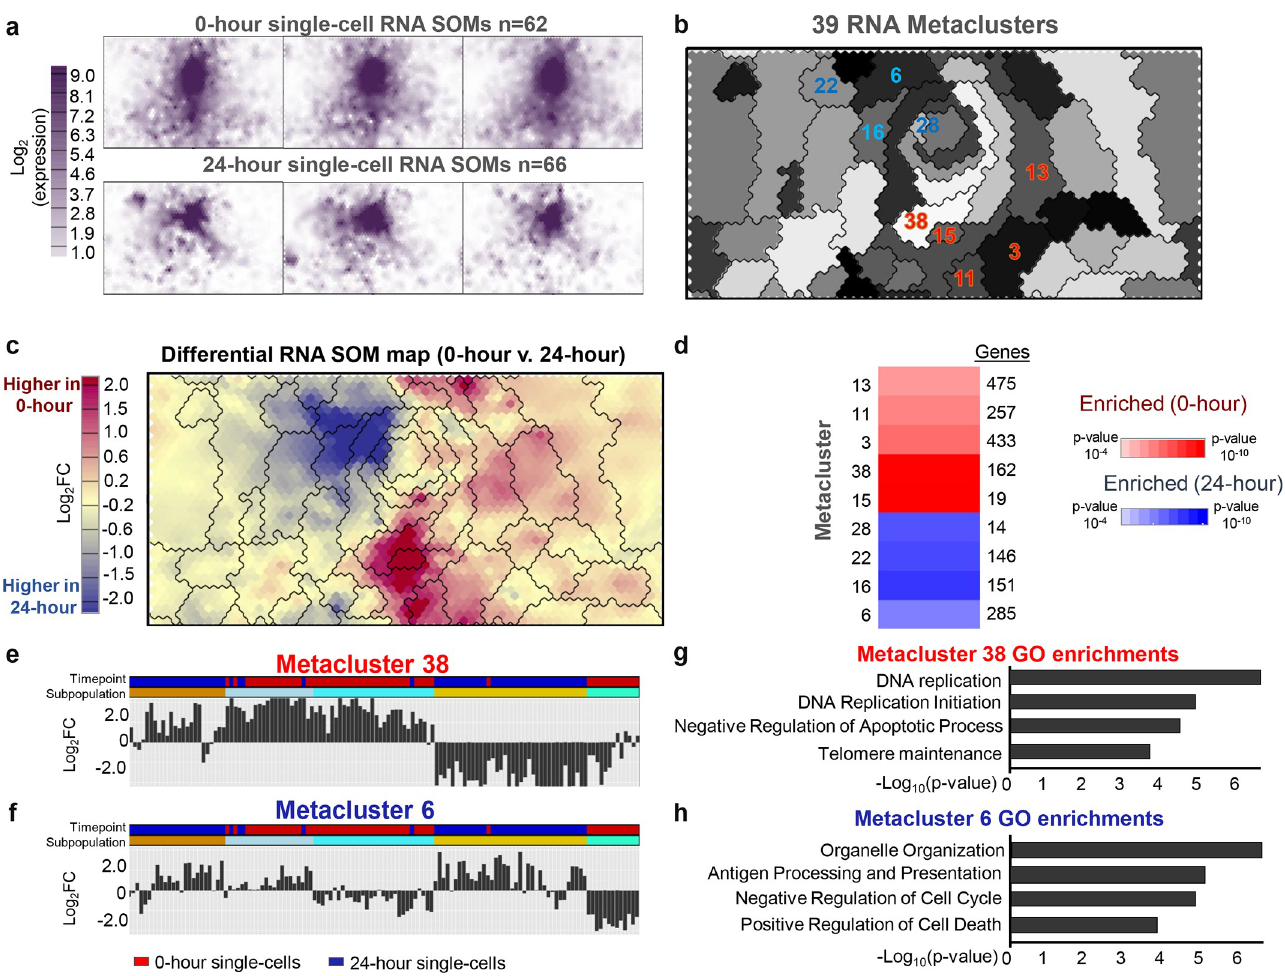
Fig 2. Single–cell gene expression patterns during cellular differentiation are profiled using SOMatic. (A) A SOM was generated for the single–cell RNA–seq dataset (0–hour 62 cells, 24–hour 66 cells). Maps for 3 cells from each time point were arbitrarily selected for display. (B) 39 metaclusters were identified using AIC scoring. Metacluster number and color were arbitrarily assigned for visualization purposes. (C) SOM difference map comparing 0–hour and 24–hour time– points. Maps for cells from 0 and 24–hour timepoints were averaged to generate a single map for each and then subtracted to create a map that represented gene expression fold change during pre–B cell development. Overlaid metacluster divisions generally follow contours of the map. (D) Trait enrichment analysis deployed on gene metaclusters revealed which are enriched in each time point. Metaclusters of interest are highlighted in panel b. (E–F) Summary showing the representative expression profile for metaclusters 38 and 6. Columns are individual cells color–coded for 0 and 24–hour time–points ordered by hierarchical clustering on every metacluster representative gene expression profile. Cell subpopulations are represented by a 40% cut on that clustering. (G–H) Top gene ontology terms for the 162 genes in metacluster 38 and the 151 genes in metacluster